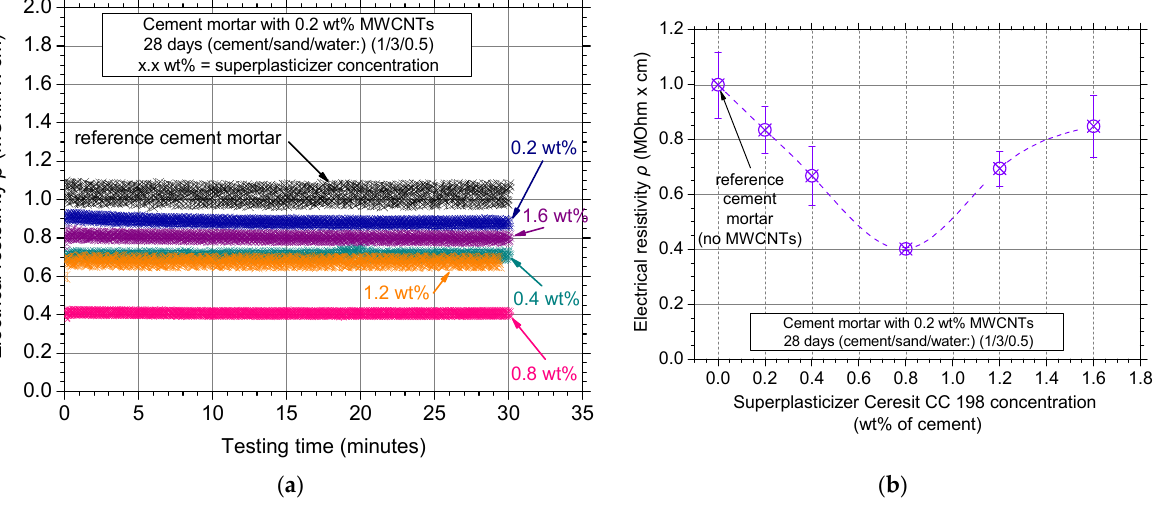
Figure 8. ( a ) Electrical resistivity curves over testing time and ( b ) average electrical resistivity values of the nanocomposites dispersed with the Ceresit CC 198 surfactant at different concentrations.